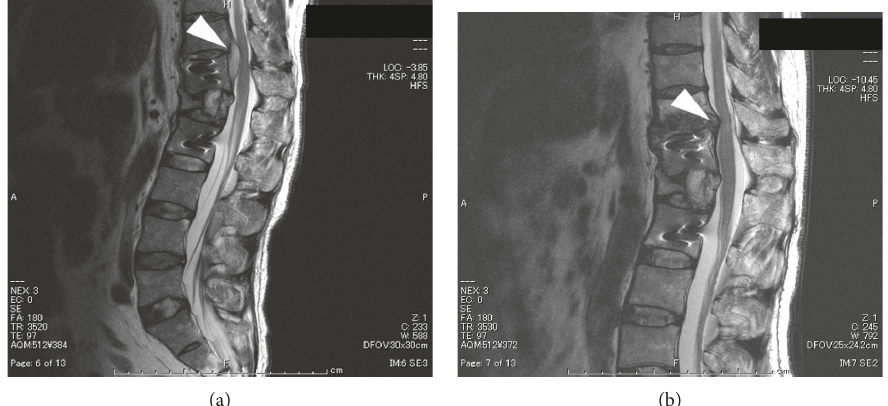
Figure 7: Case 3: sagittal T2-weighted MRI before (a) and after (b) administration of antibiotics. An abscess was observed in (a) and was not detectable in (b).